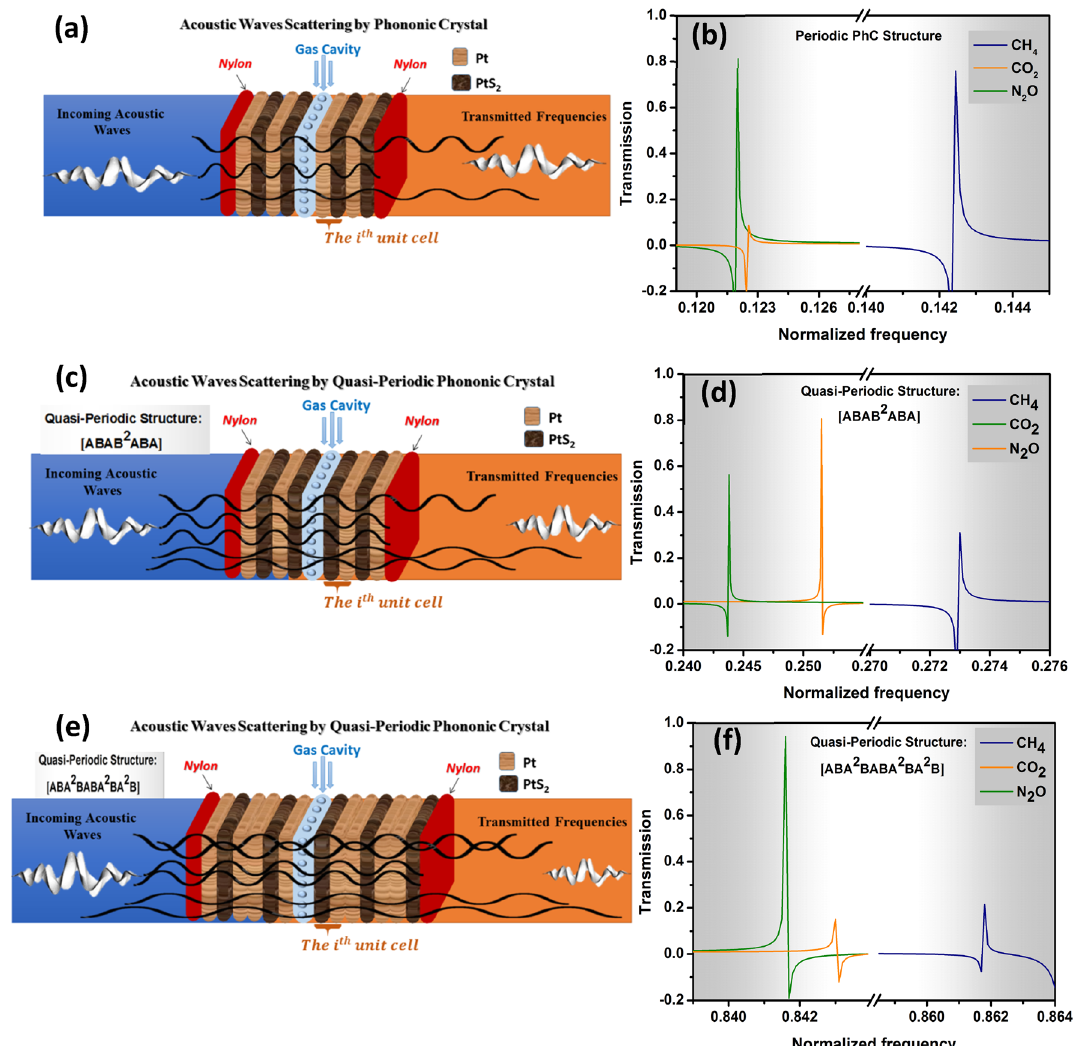
Figure 2. ( a , c , e ) introduced the periodic and F(5), FC(7, 1) quasi-periodic PhC gas sensor structures respectively, ( b , d , f ) Fano resonance transmitted spectra versus normalized frequency towards N 2 O, CH 4 , and CO 2 greenhouse gases at room temperature of periodic and F(5), FC(7, 1) quasi-periodic PhC gas sensor structures